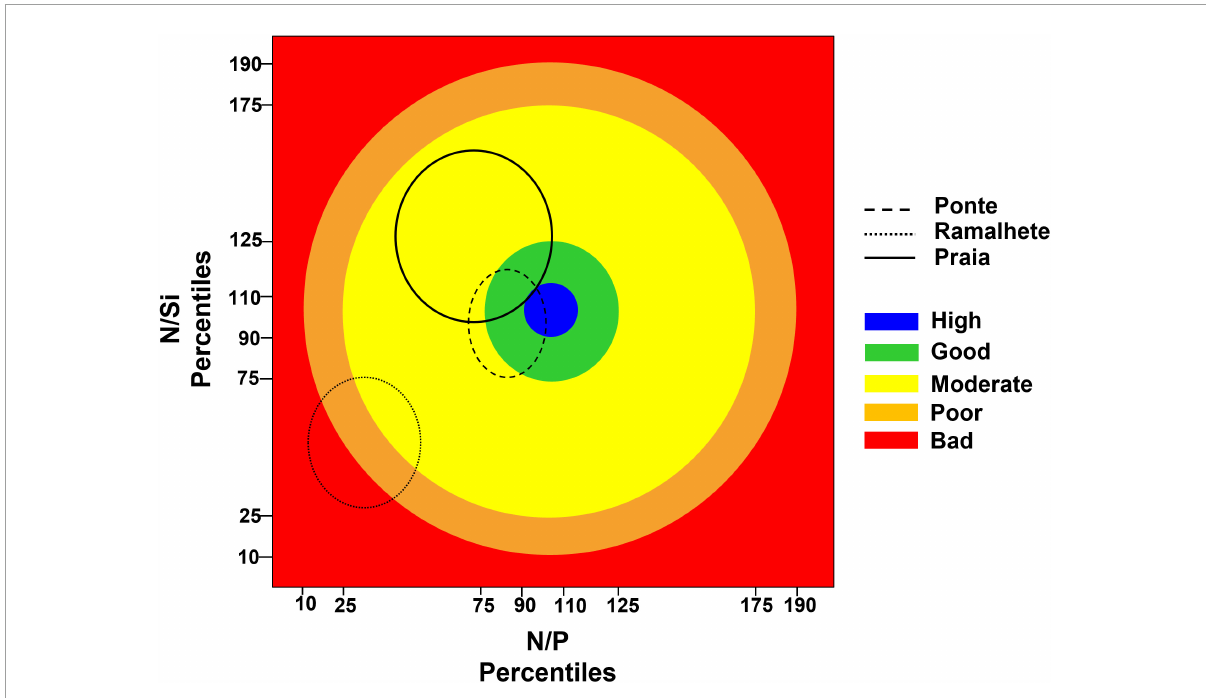
FIGURE2 N:P and N:Si calculated from the data for the three stations Praia, Ponte and Ramalhete that were used in the boundaries intercalibration exercise for the Water Framework Directive.